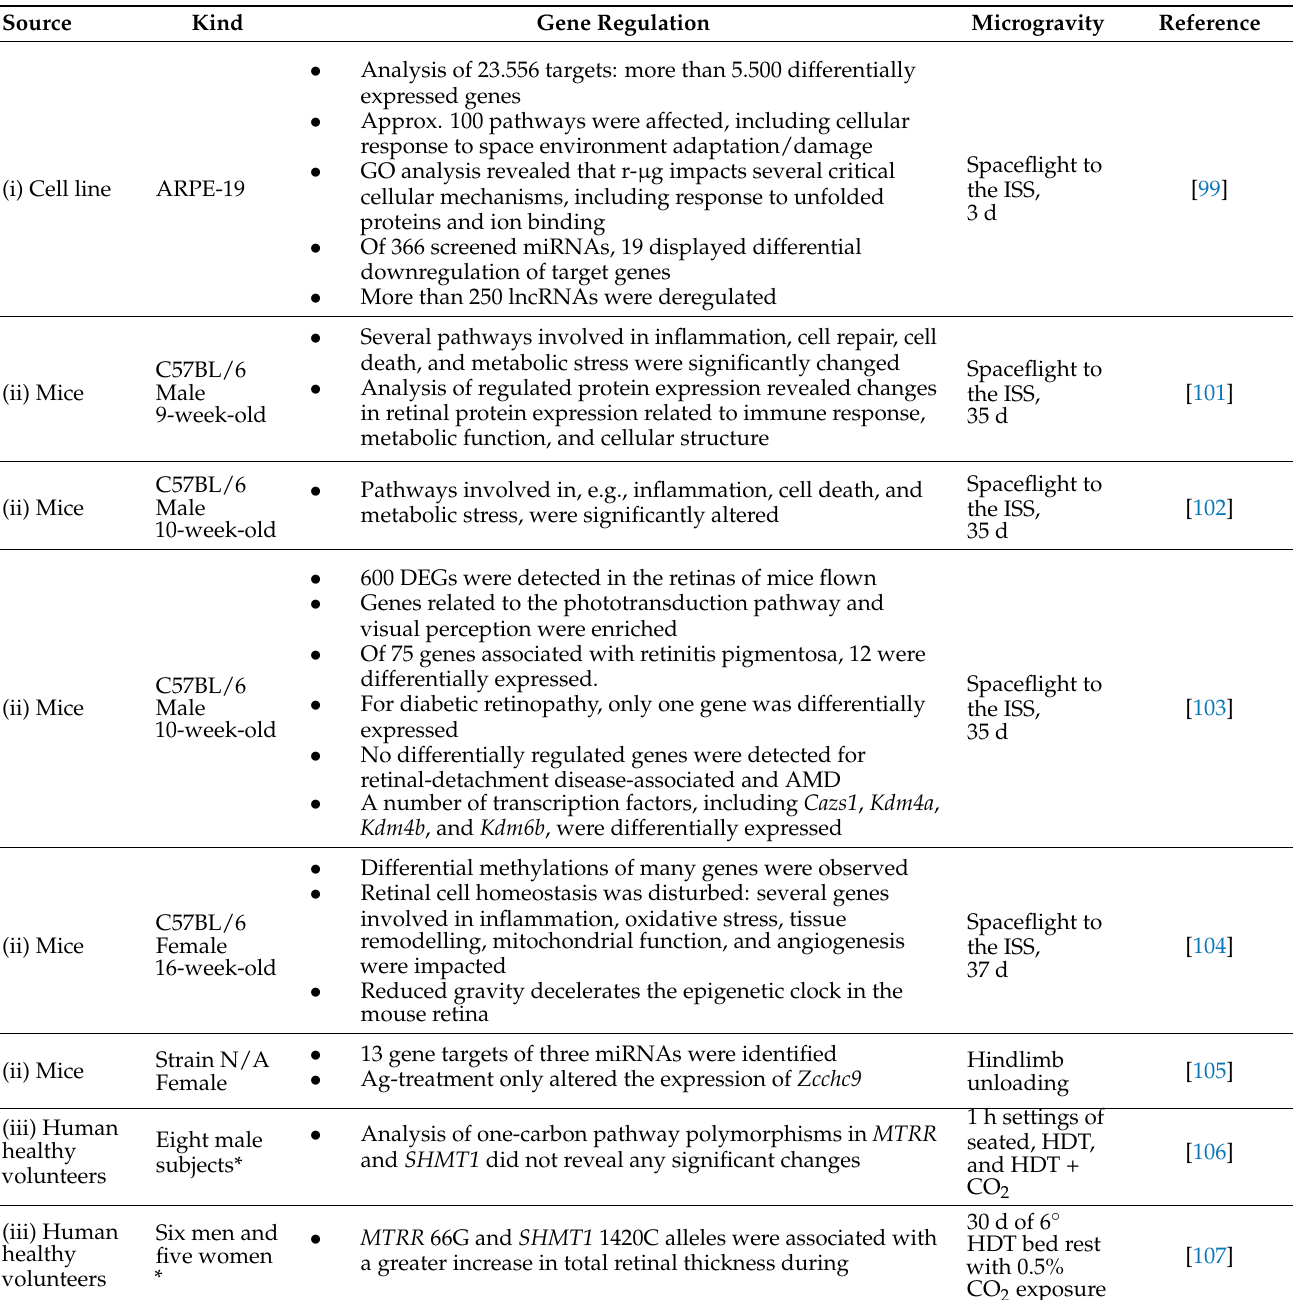
Table 3. Changes in gene regulation of (i) eye-related cells subjected to r- µ g , (ii) eye tissue isolated from animals exposed to microgravity conditions, or (iii) healthy human volunteers exposed to head-down